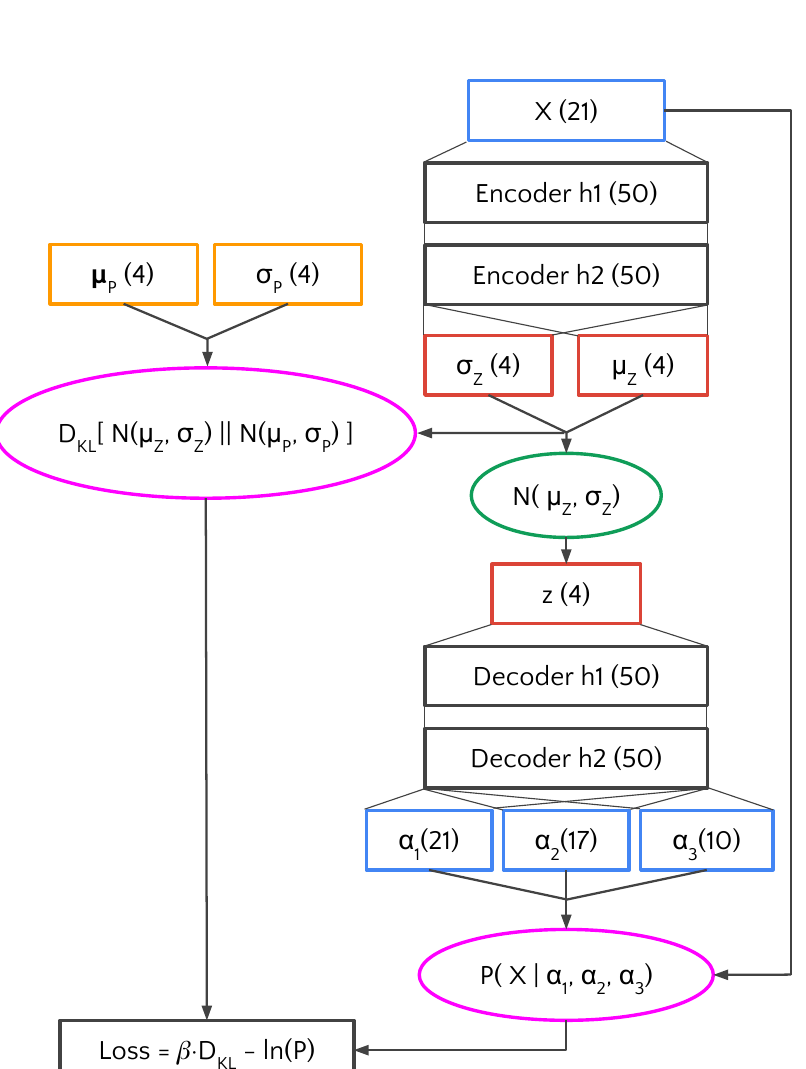
Figure 3 . Schematic representation of the VAE architecture presented in the text. The size of each layer is indicated by the value within brackets. The blue rectangle X represents the input layer, which is connected to a stack of two consecutive fully connected layers (black boxes). The last of the two black box is connected to two layers with four nodes each (red boxes), representing the (cid:22) z and (cid:27) z parameters of the encoder pdf p ( z j x ). The green oval represents the sampling operator, which returns a set of values for the 4-dimensional latent variables z . These values are fed into the decoder, consisting of two consecutive hidden layers of 50 nodes each (black boxes). The last of the decoder hidden layer is connected to the three output layers, whose nodes correspond to the parameters of the predicted distribution in the initial 21-dimension space. The pink ovals represent the computation of the two parts of the loss function: the KL loss and the reconstruction loss (see text). The computation of the KL requires 8 additional learnable parameters ( (cid:22) p and (cid:27) p , represented by the orange boxes on the top-left part of the (cid:12)gure), corresponding to the means and RMS of the four-dimensional Gaussian prior p ( z ). The total loss in computed as described by the formula in the bottom-left black box (see eq. (4.3)).